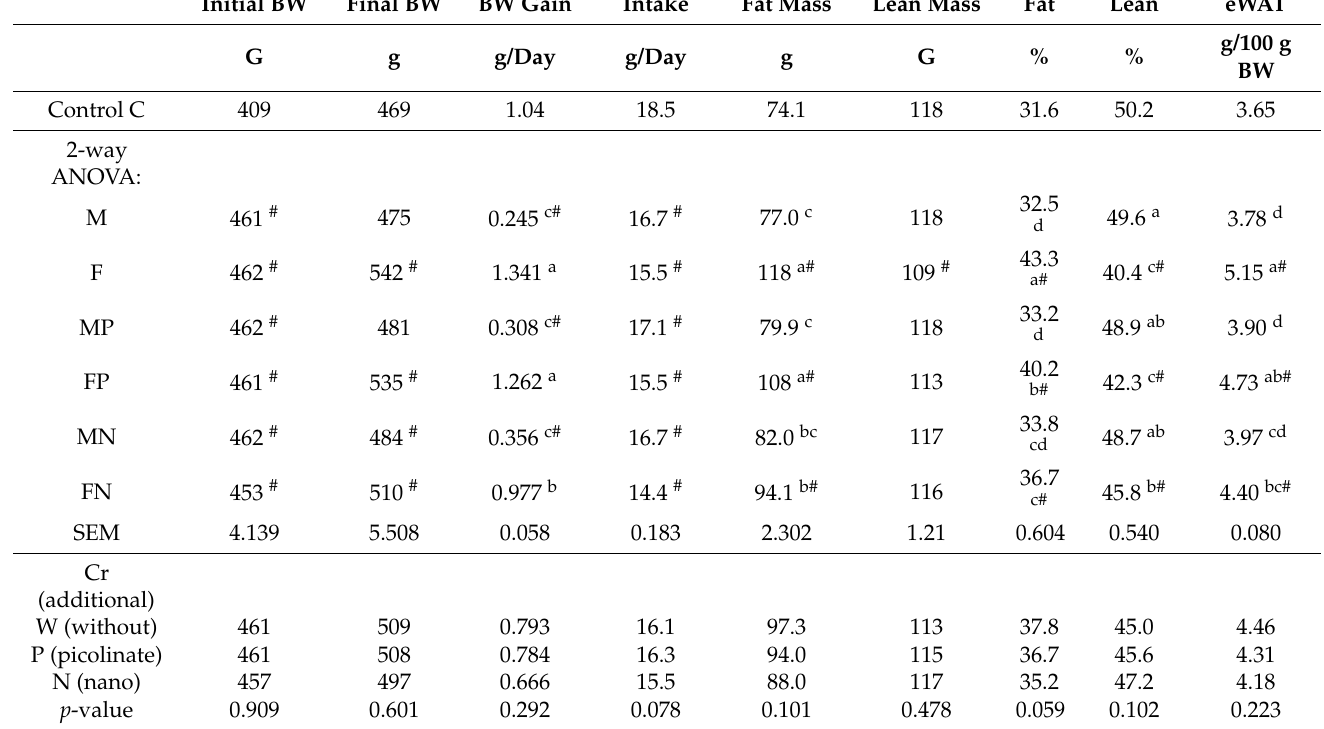
Table 1. Body weight, feed intake and NMR (nuclear magnetic resonance) parameters in rats fed experimental diets ( n = 12 per group)